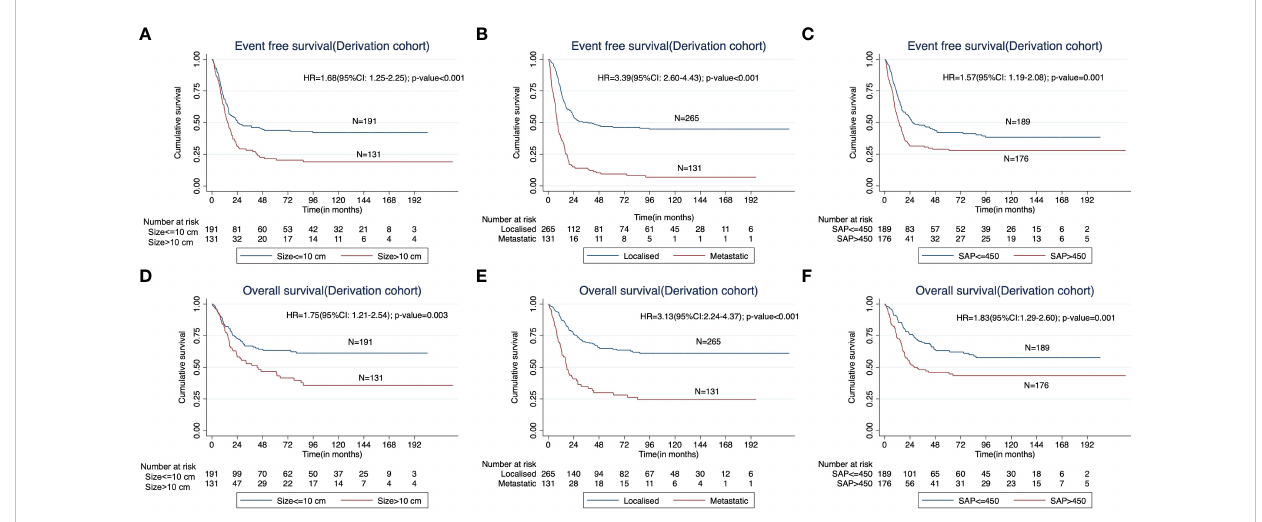
FIGURE 1 Kaplan Meier curves showing impact of (A) the baseline tumor size (< 10 cm versus > 10 cm), (B) presence of metastases at presentation, and (C) higher baseline serum alkaline phosphatase ( ≤ 450IU/L vs >450IU/L) on the event free survival (EFS) in the derivation cohort. The impact of the corresponding factors on overall survival (OS) is shown in (D – F)